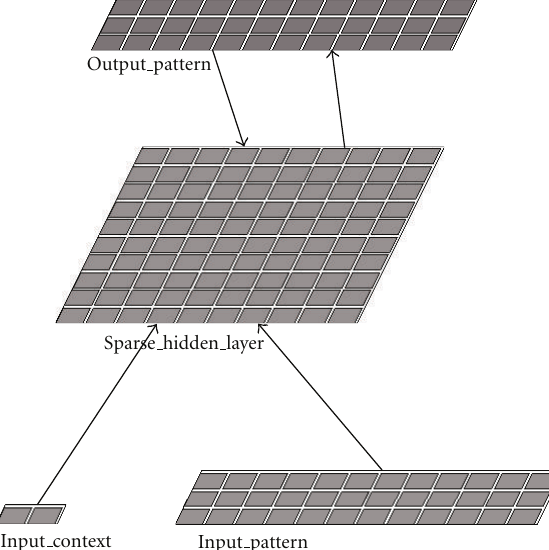
Figure 1: The Leabra network.